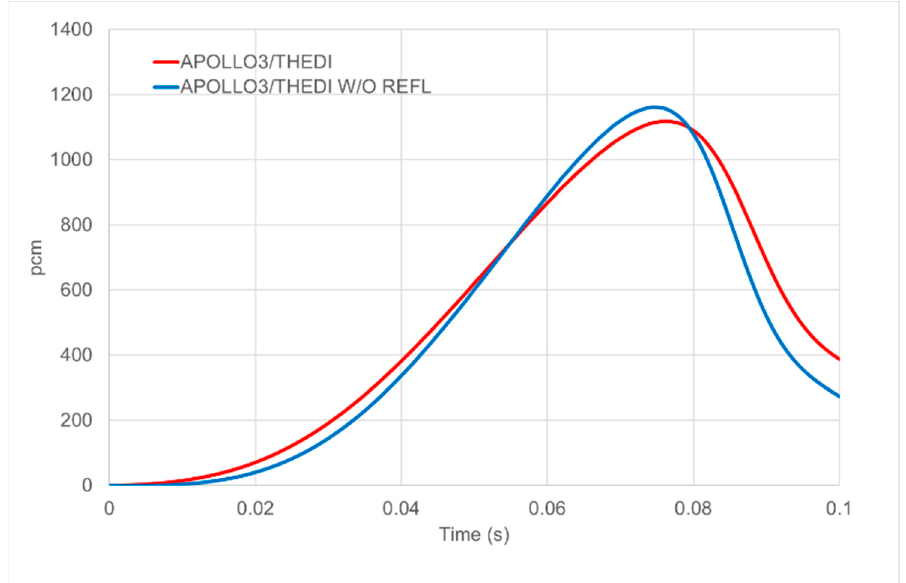
Figure 28. The 19 Hexagonal FA core case (based on APOLLO3 ® /THEDI calculations)—axial reflector modeling: reactivity behavior.